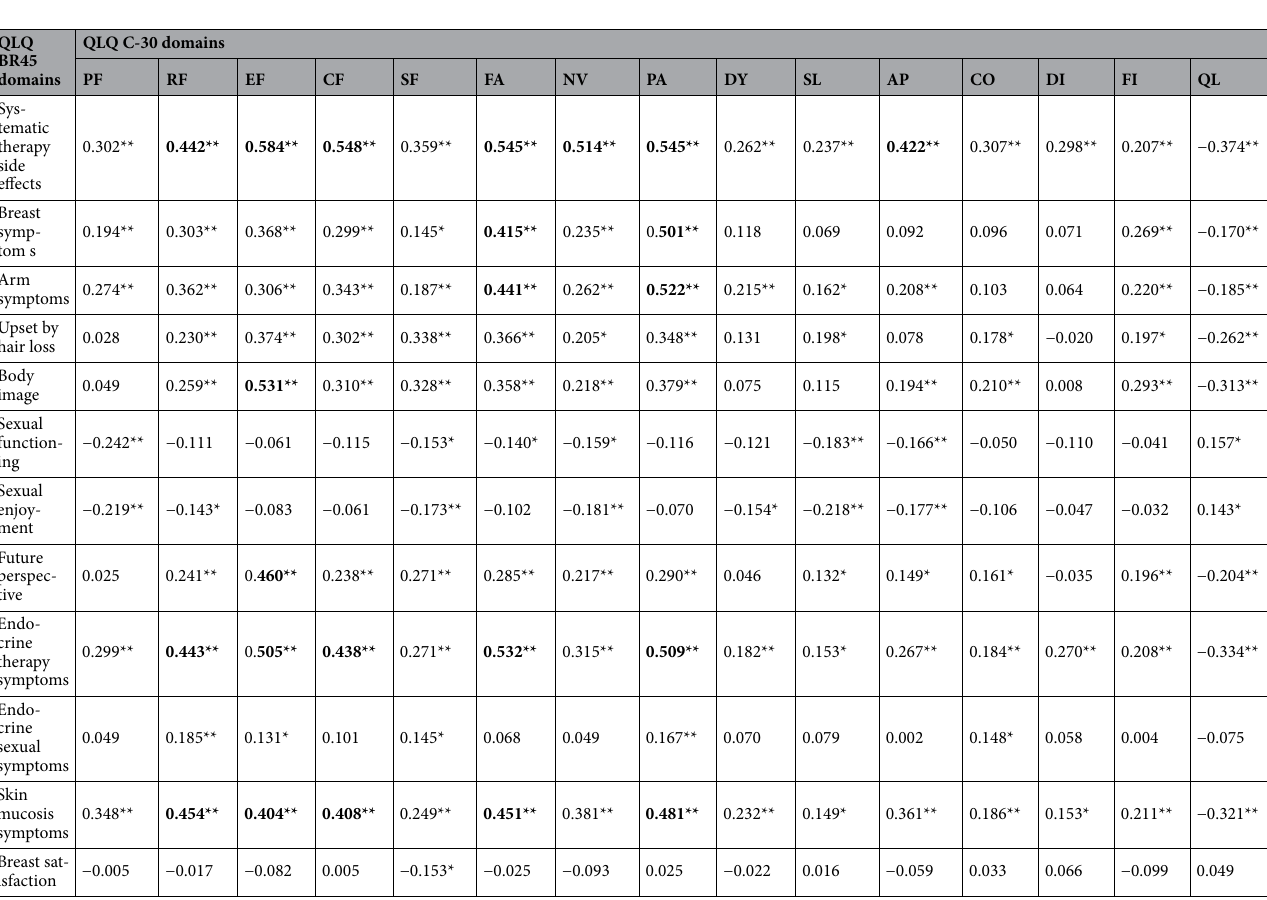
Table 5. Inter-scale correlations among scales of EORTC QLQ BR45 and with scales of EORTC QLQ-C30 Amharic version among breast cancer patients in Ethiopia, 2021. PF physical functioning, RF role functioning, EF emotional functioning, CF cognitive functioning, SF sexual functioning, FA fatigue, NV nausea and vomiting, PA pain, DY dyspnea, SL sleep lack, AP loss of appetite, CO constipation, DI diarrhea, FI fatigue, QL quality of life. Significant values are in bold. *P < 0.05, **P <